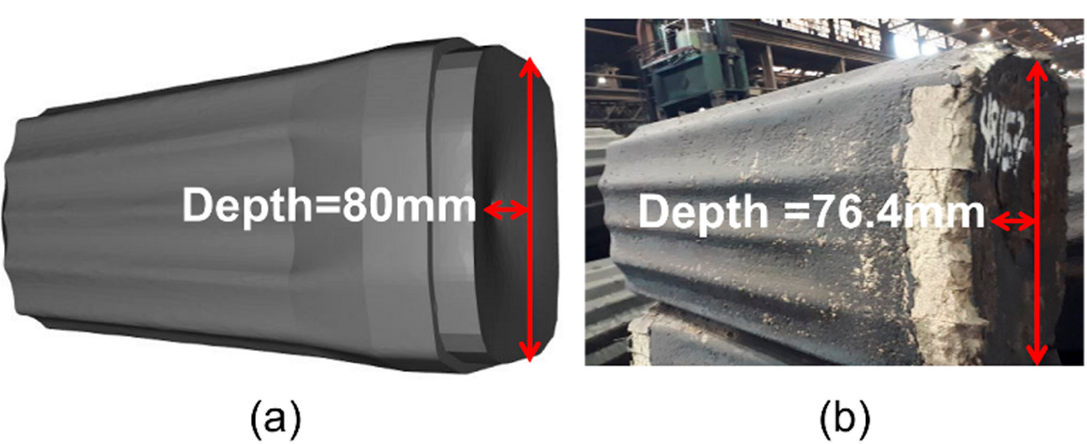
Figure 4. Shrinkage cavity of ingot 12 MT at the end of solidification: ( a ) Predicted result, ( b ) Result from a real ingot .